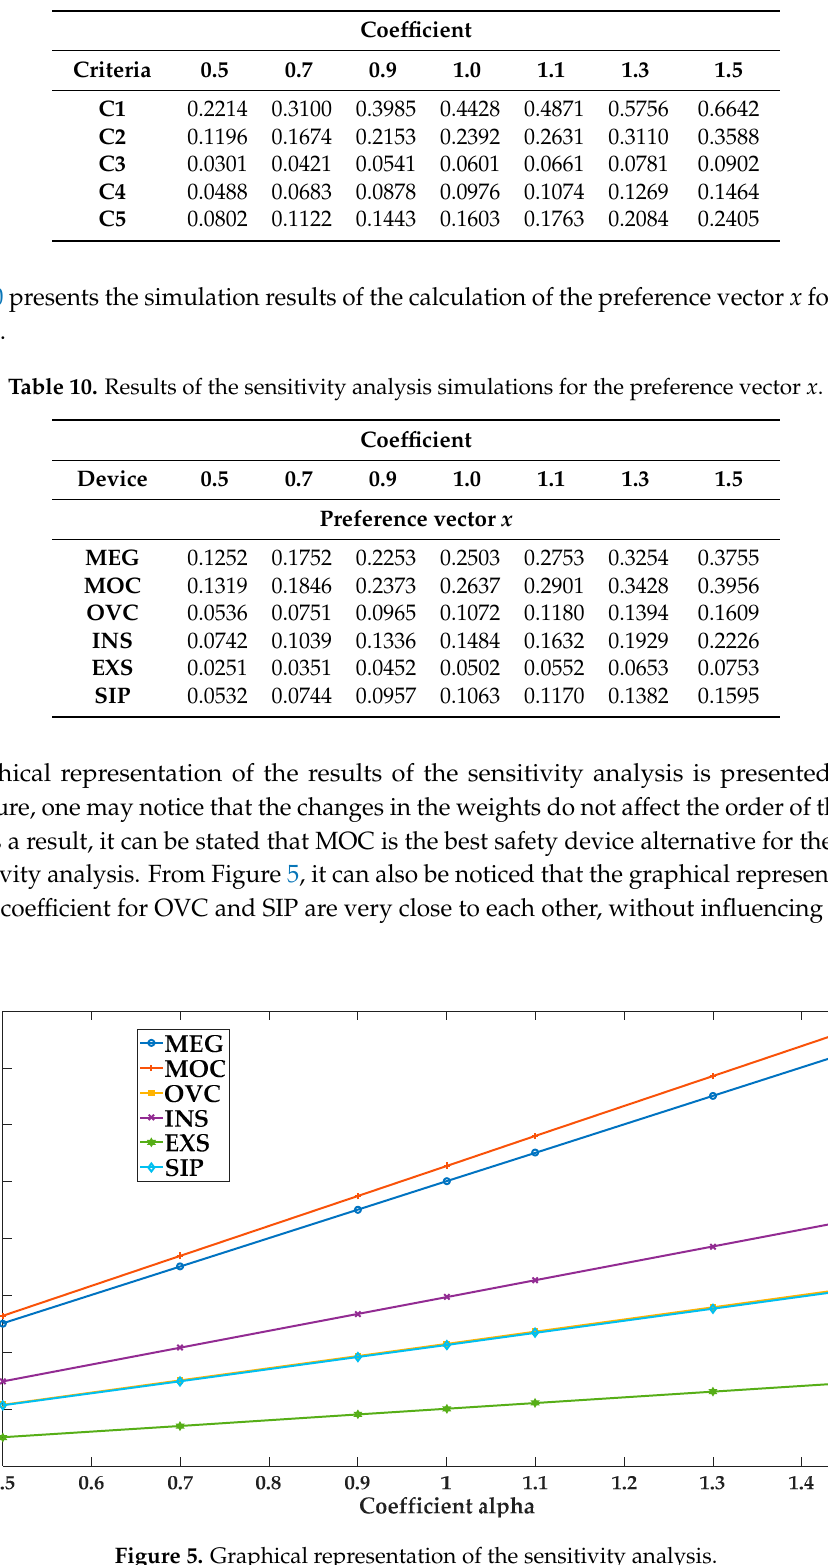
Table 9. Sensitivity analysis for the weights.